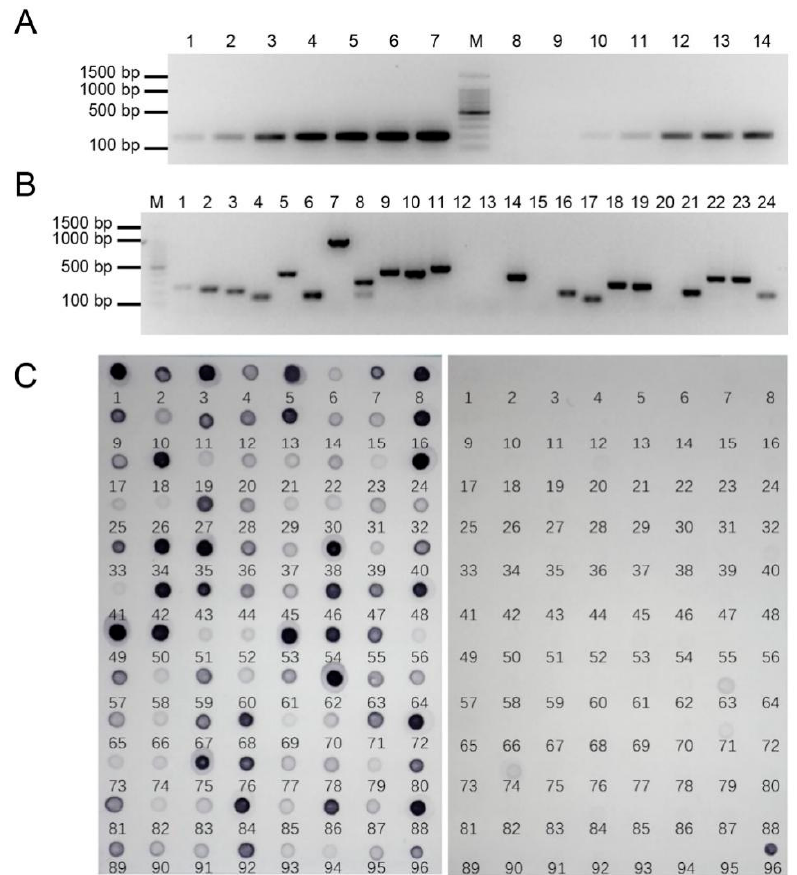
Figure 2. The detection of PCR and dot-blot screening of E. arundinaceus -specific clones. ( A ) The efficiency of suppression subtractive hybridization. M: 100bp Marker; 1–7: PCR was performed on unsubtracted secondary PCR products with amplification cycles of 18, 21, 24, 27, 30, 33, and 36; 8–14: PCR was performed on subtracted secondary PCR products with amplification cycles of 18, 21, 24, 27, 30, 33, and 36. ( B ) The detection result of positive clones. M: 100 bp DNA Ladder; 1–24: Randomly selected clones. ( C ) The detection result of RDB. The probe of gDNA from HN92-77 and sugarcane in left and right nylon membrane, respectively. The plasmid of 45S rDNA as positive control in No. 96.